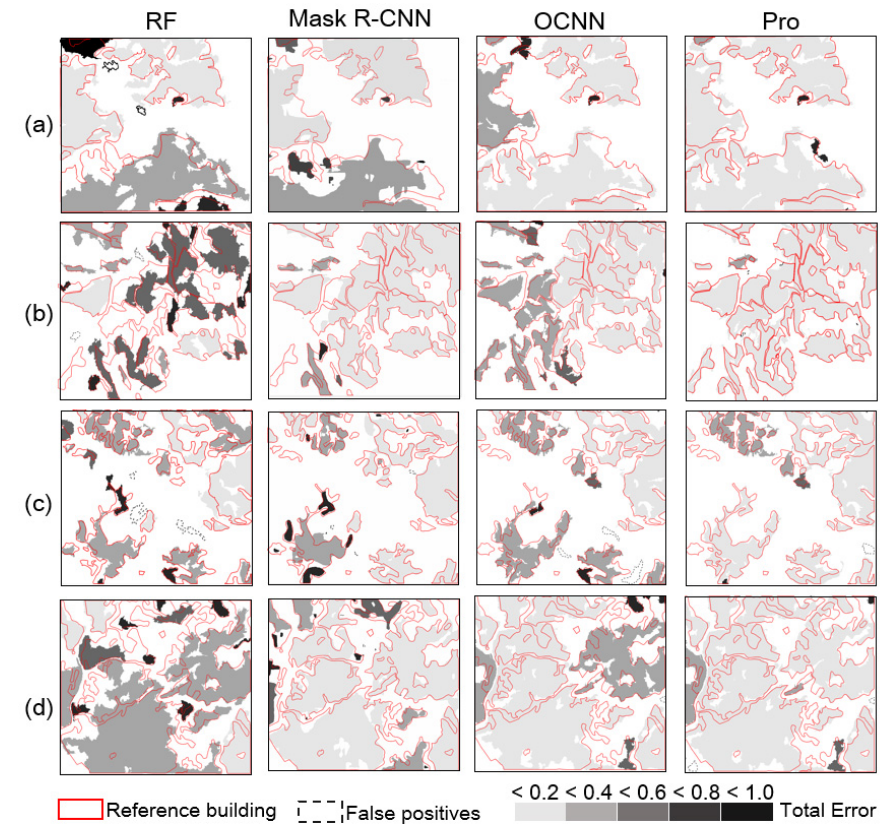
Figure 7. Distribution of the total error TC ( M i ) index of the tea plantation objects classified by the RF, Mask R-CNN, OCNN, and proposed method (labeled as Pro) on ( a – d ) test regions. False positives refer to the extracted tea plantation objects that do not overlap with the reference